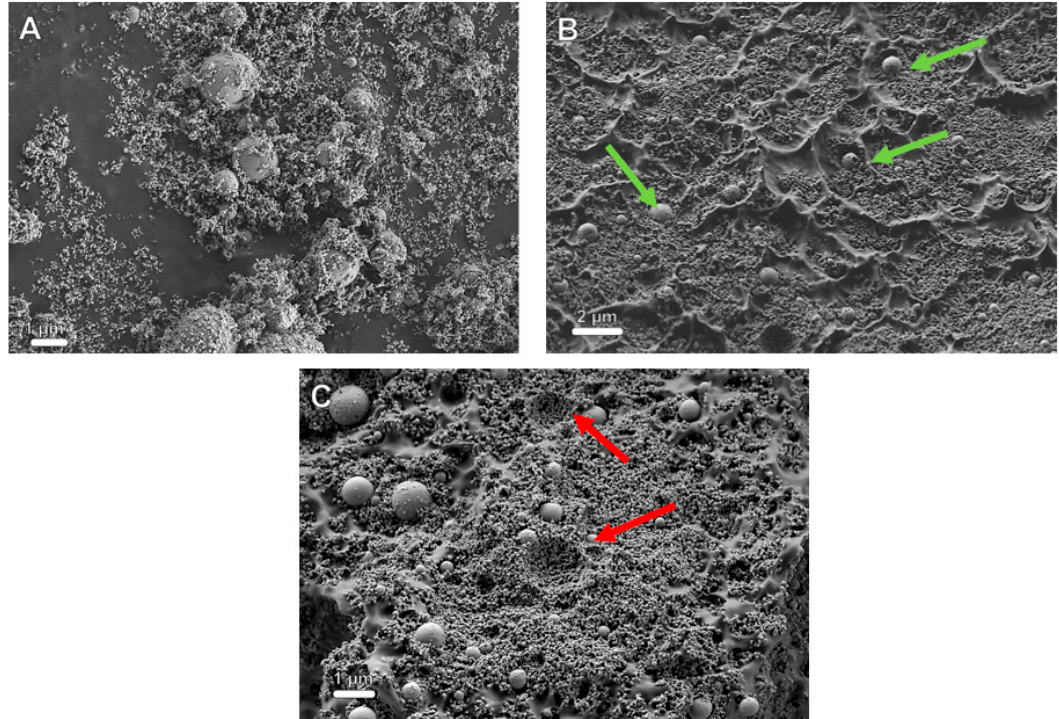
Figure 3. HR-SEM images (secondary electrons—SE mode) of pure HA powder ( A ) and PLLA film reinforced with 40 wt% HA observed in the SE mode at two magnifications, scale bars are 2 µ m ( B ) and 1 µ m ( C ). Green arrows point to the spherical agglomerates of HA nanoparticles. Red arrows point to pits formed by the pullout of the HA agglomerates during film breakage.